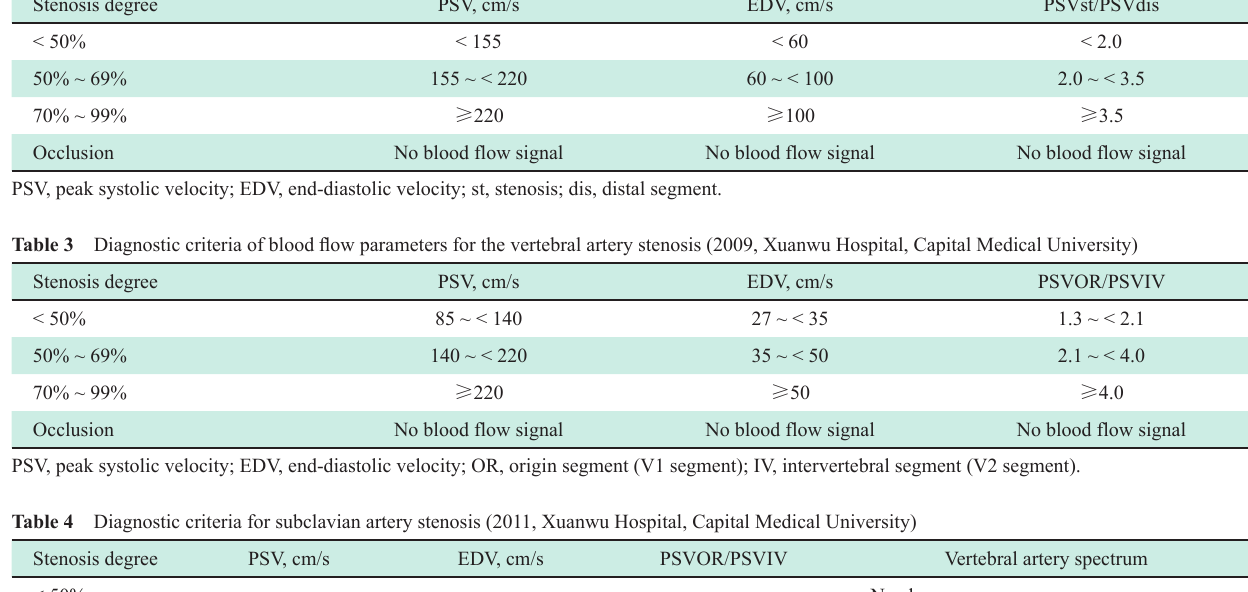
Table 2 Differentiation of moderate from severe carotid stenosis (2006, Xuanwu Hospital, Capital Medical University) Stenosis degree PSV, cm/s